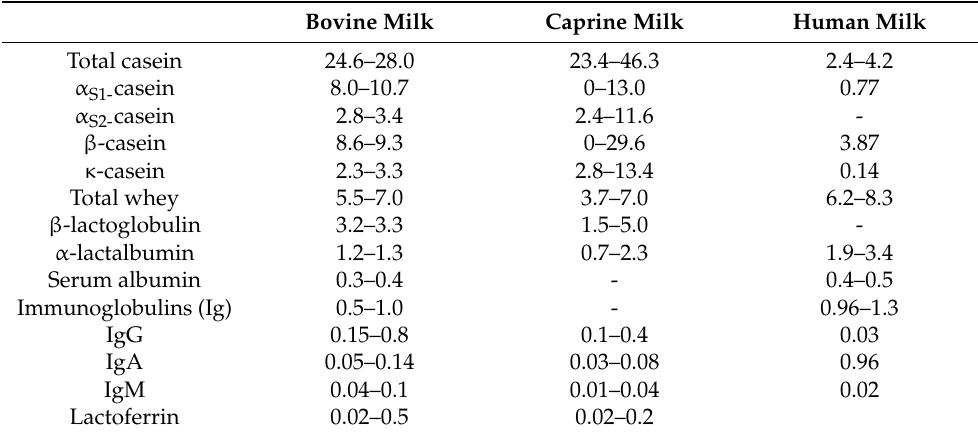
Table 1. Concentration (g/L) of individual proteins in mature bovine, caprine and human milk. Reprinted with permission from Ref. [20]. Copyright 2014